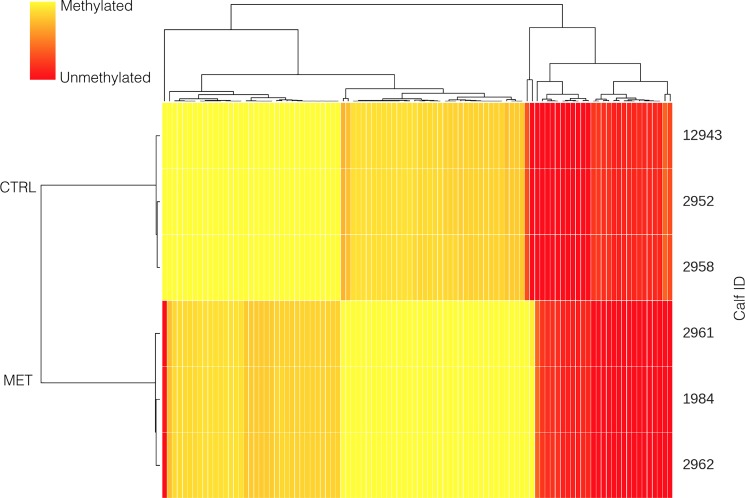
Cluster analysis of CpG sites differentially methylated (p < 0.01) in the offspring born to lactating dams that received a supplementation of methyl donors or a placebo during early pregnancy.Control dams received a placebo, whereas MET dams received weekly administrations of 200 mg of folic acid and 20 mg of vitamin B12.